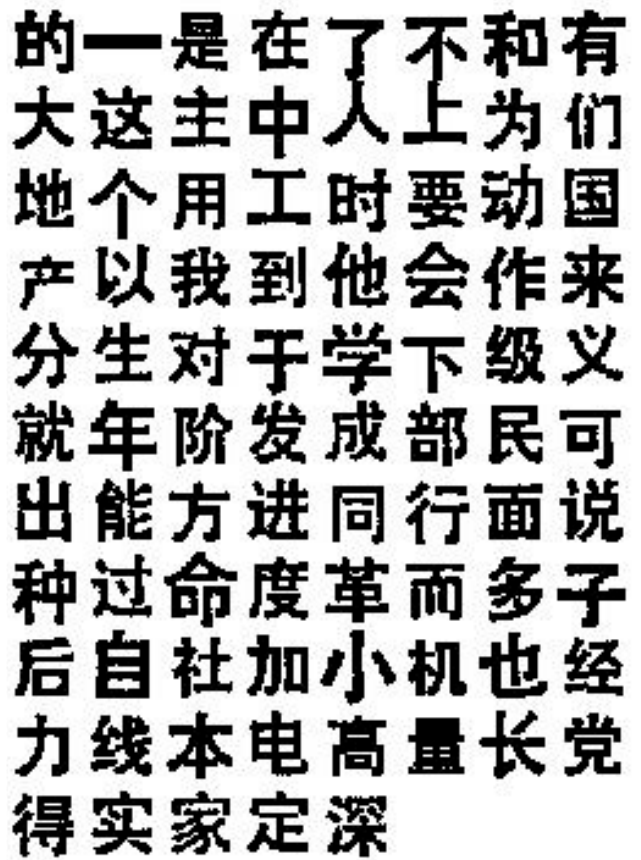
Figure 1. The printed Chinese character dataset.